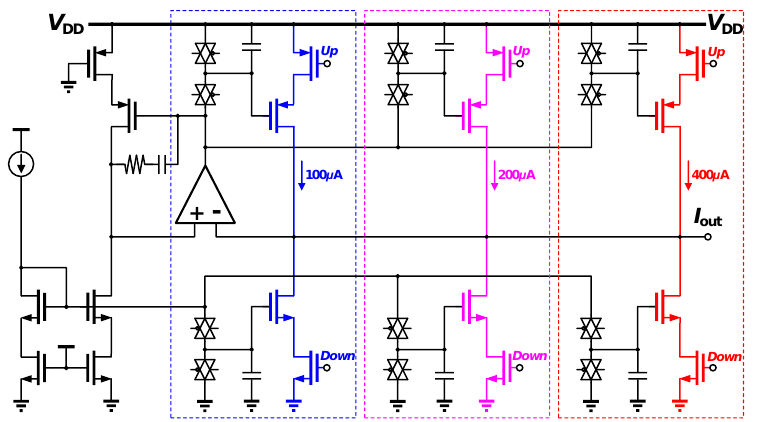
Figure 9. Schematic of the programmable charge pump (CP).